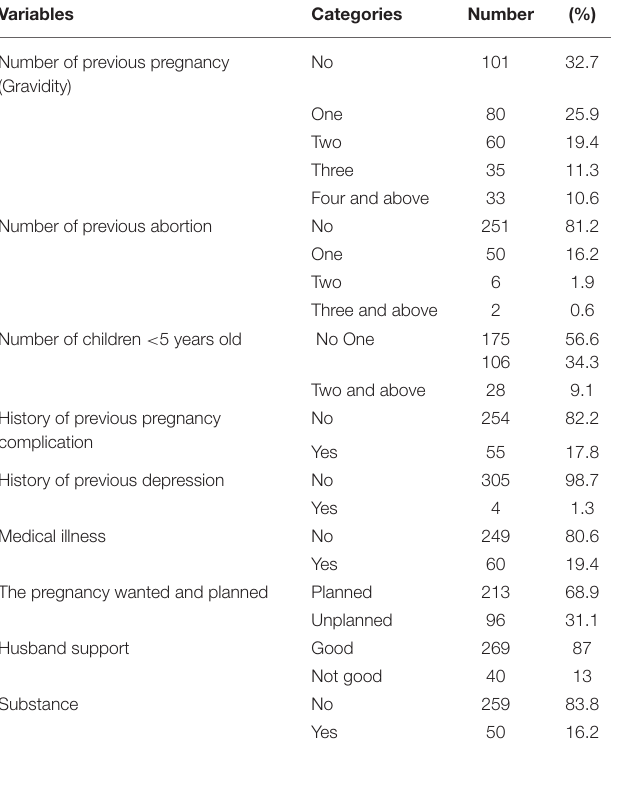
TABLE 2 | Obstetric characteristics of pregnant women who attended ANC service and participated in the study during study period at Wolayta Sodo teaching and referral Hospital, June 2018 (created by authors).